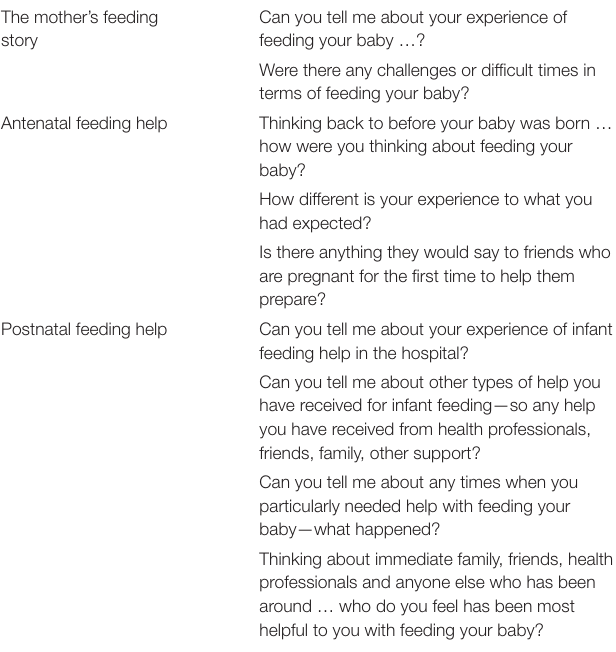
TABLE 1 | Examples of interview questions. The mother’s feeding story